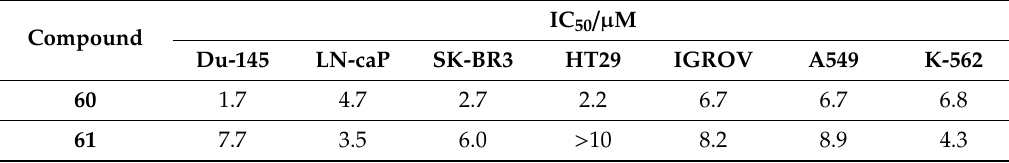
Table 3. Growth inhibitory activity of granulatamides A ( 60 ) and B ( 61 ) against various tumor cell lines